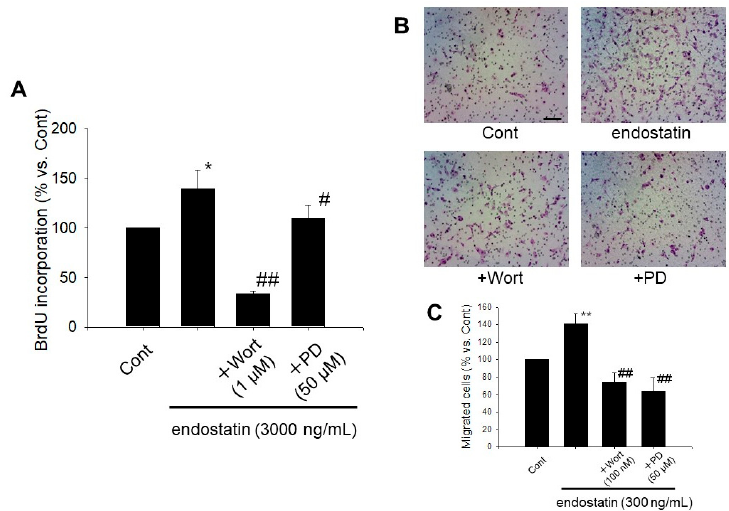
Figure 4. Wortmannin (a phosphoinositide 3-kinase inhibitor) or PD98059 (a mitogen-activated protein kinase/ERK kinase inhibitor) inhibited endostatin-induced proliferation and migration of myofibroblasts. ( A ) After the cells were seeded at a density of 1 × 10 4 cells/well in a 96-well culture plate and starved (in 0.5% FBS), they were treated with endostatin (3000 ng/mL) or vehicle for 24 h in the presence or absence of wortmannin (Wort: 1 µM, 30 min pre-treatment) or PD98059 (PD: 50 µM, 30 min pre-treatment). The cells were incubated with a BrdU reagent (20 µL/well) for 24 h, and BrdU incorporation was detected by a colorimetric method using an anti-BrdU antibody and tetramethylbenzidine solution. The normalized BrdU incorporation relative to Cont are shown as mean ± S.E.M. ( n = 9). *, p < 0.05 vs. Cont, #, p < 0.05, ##, p < 0.01 vs. endostatin-alone treatment; ( B , C ) Migration of myofibroblasts was determined by a Boyden chamber assay. The cells at a density of 1 × 10 5 cells/100 µL serum free medium were seeded in the upper-chamber coated with 2% gelatin, and endostatin (300 ng/mL) or vehicle was treated in the bottom well for 24 h. Wortmannin (Wort: 100 nM) or PD98059 (PD: 50 µM) was pre-treated in both upper and lower chambers 30 min before endostatin-stimulation. ( B ) Representative pictures of Giemsa-stained migrated cells are shown. Scale